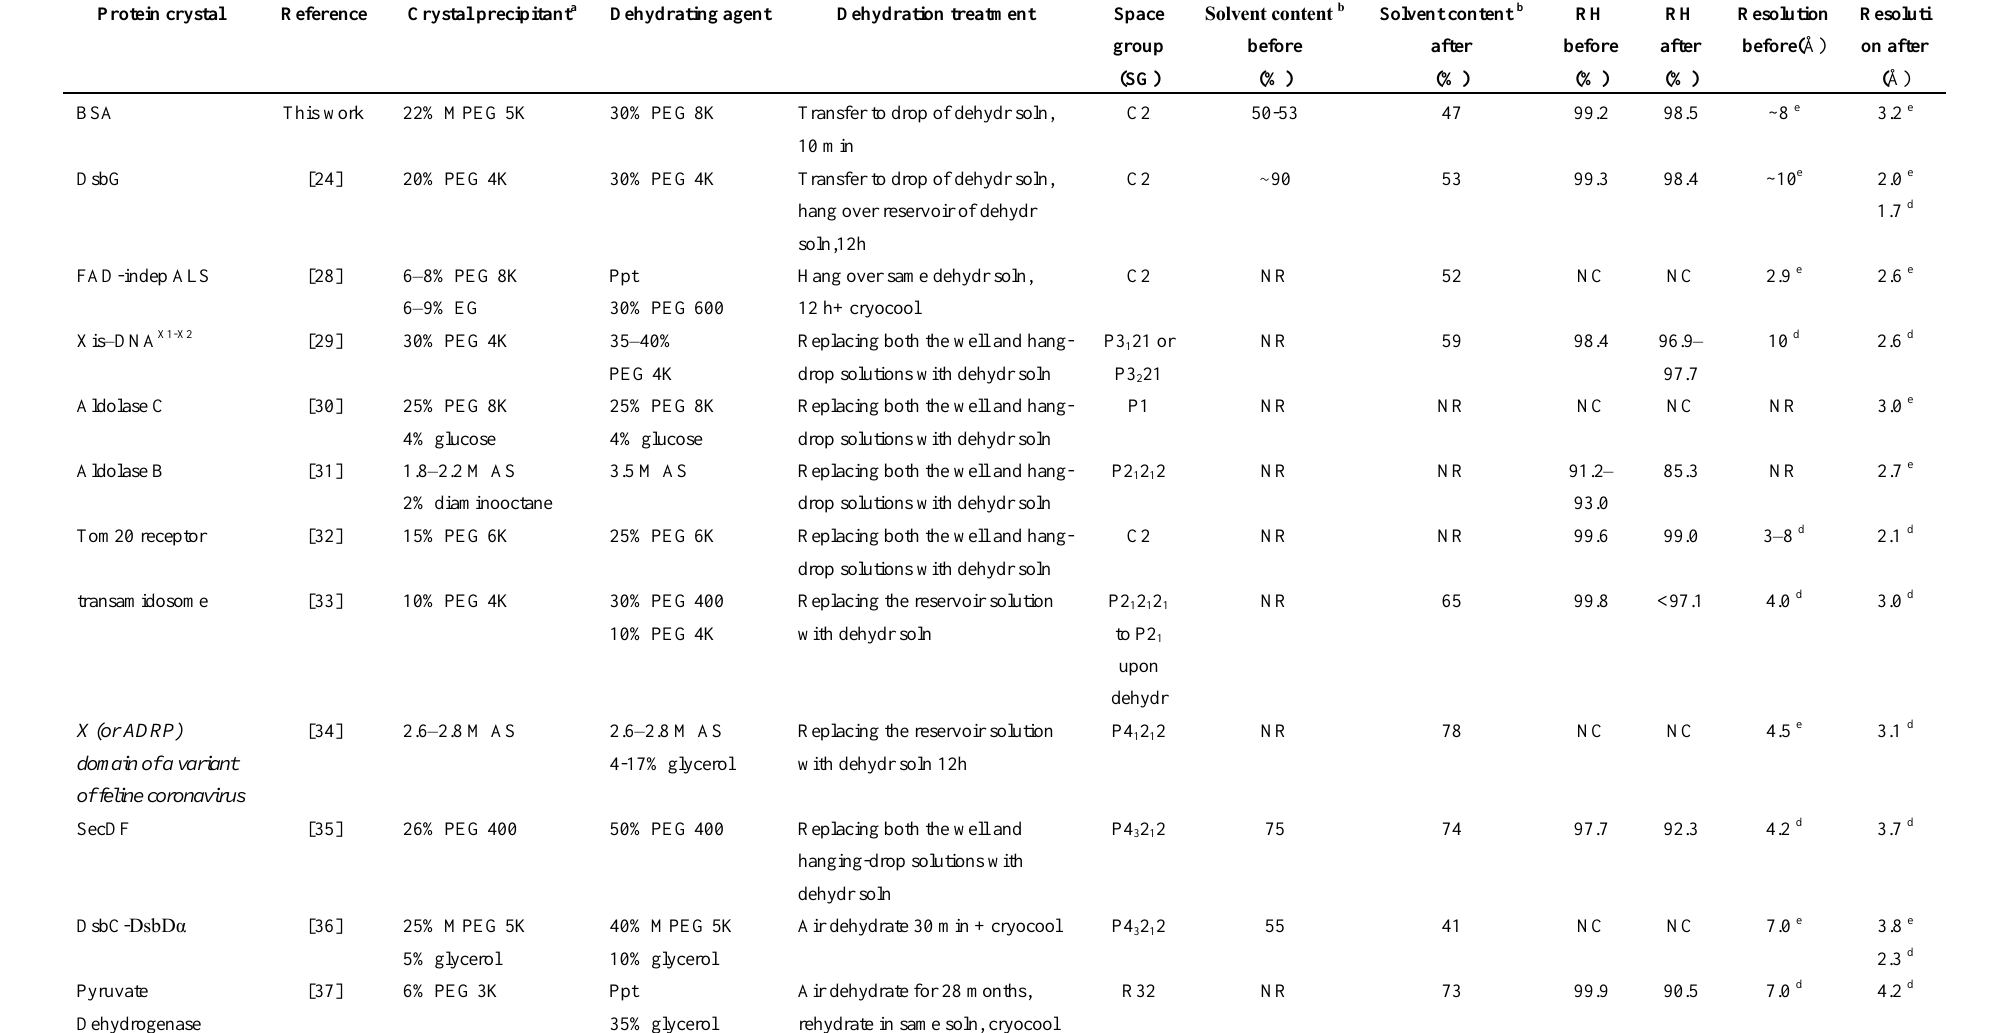
Table 1. Dehydration of protein crystals and effect on solvent content and diffraction